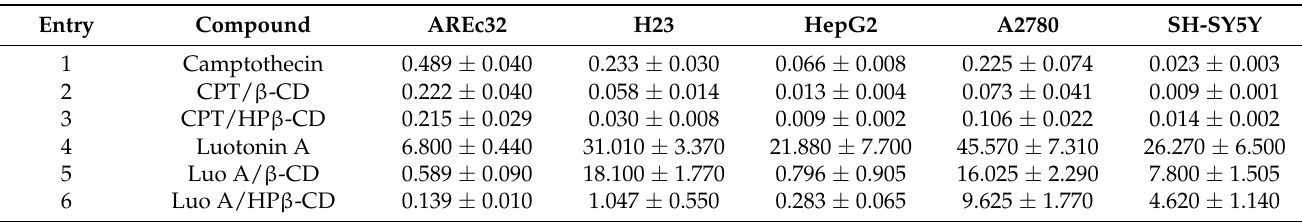
Table 3. Cytotoxicity induced in several cancer cell lines after 72 h incubation with camptothecin, luotonin A and their complexes with β -CD and HP β -CD, expressed as CC 50 ( µ M).